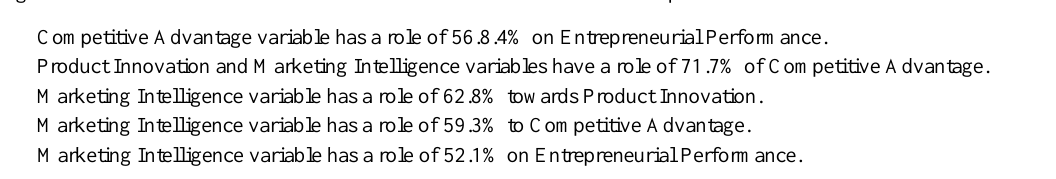
Table 10: Coefficient of